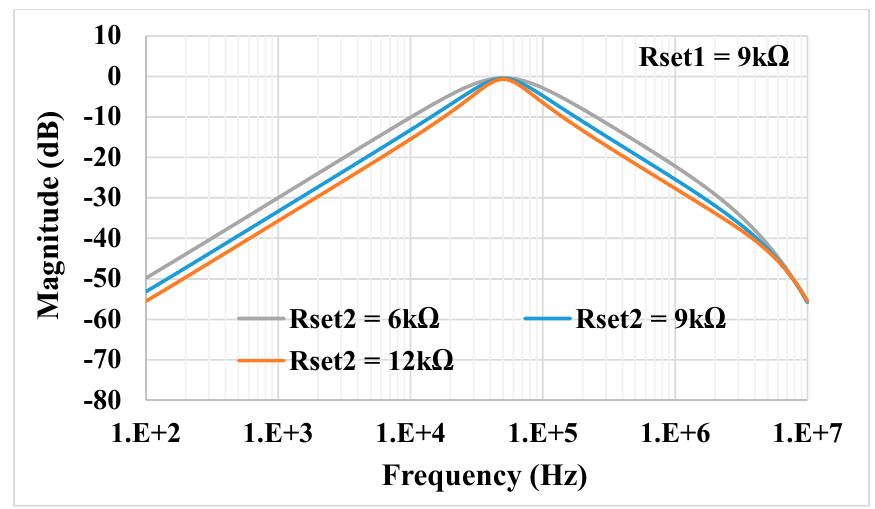
Figure 11. Tunability of the band-pass (BP) filter for different R set2 and the constant R set1 .